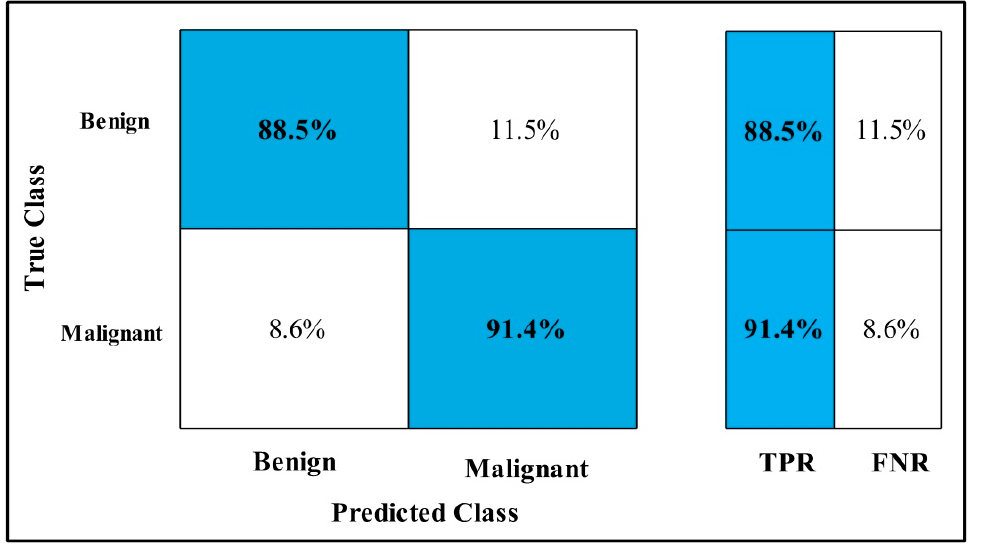
Figure 9. MEWOA TPR on MobilenetV2 CBIS-DDSM.